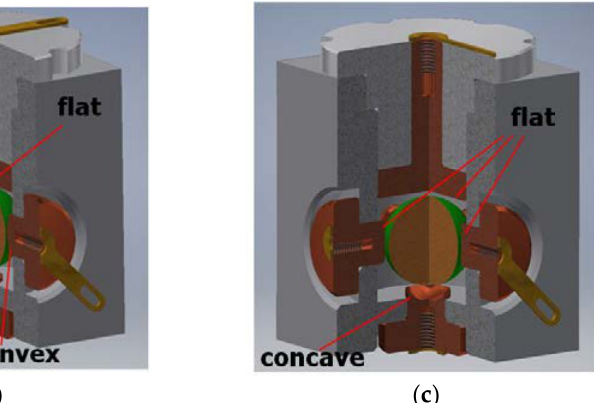
(short-circuiting of the upper side and two lower side electrodes). circuiting of the upper side and two lower side electrodes).